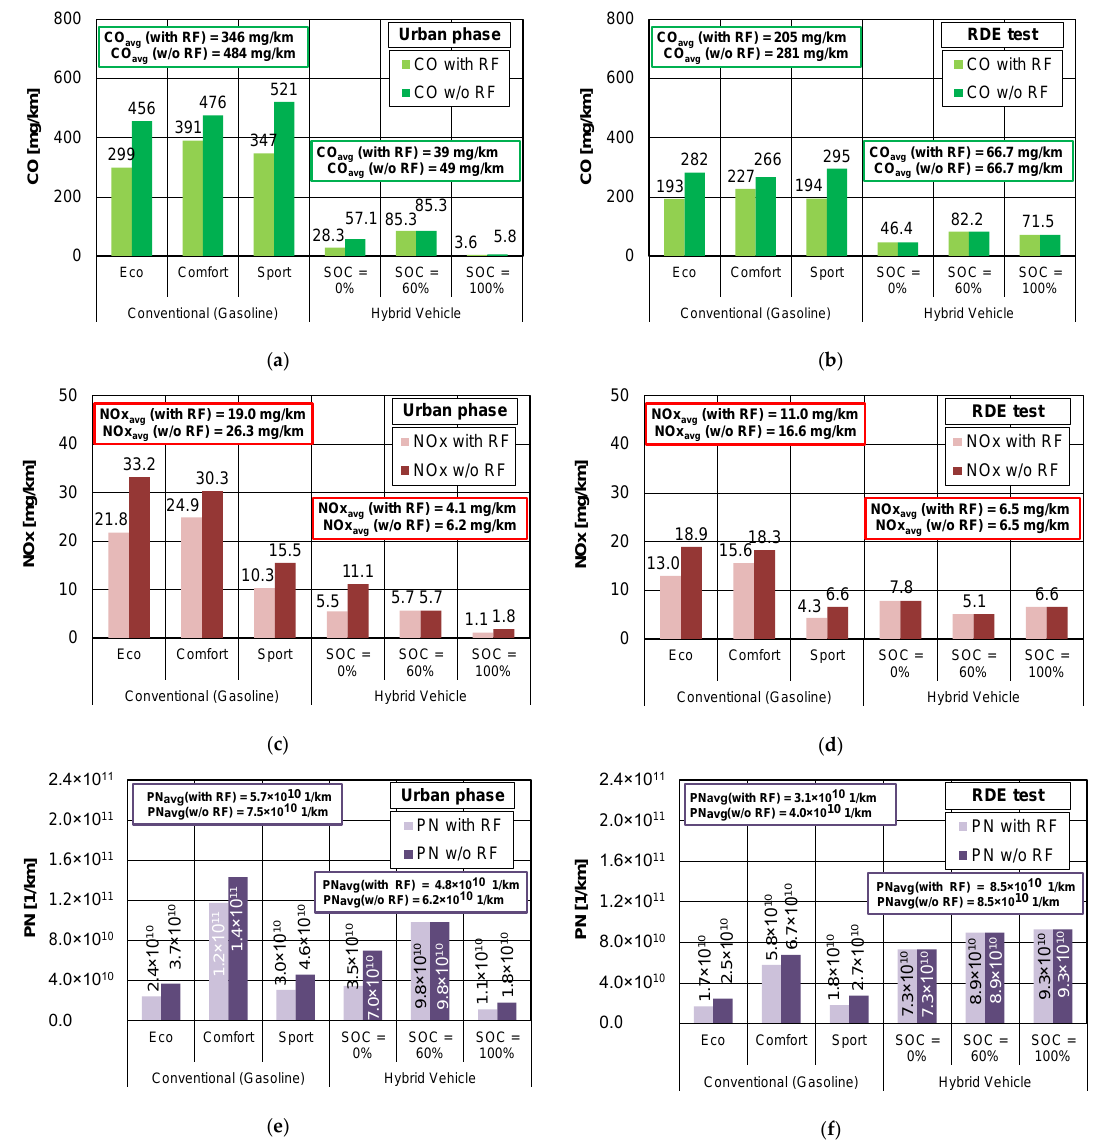
Figure 11. Values of the road emissions of individual exhaust components determined using the RF emission factors in the urban phase of the RDE test ( a , c , e ) and the entire RDE test ( b , d , f ) for all the investigated vehicles fitted with combustion